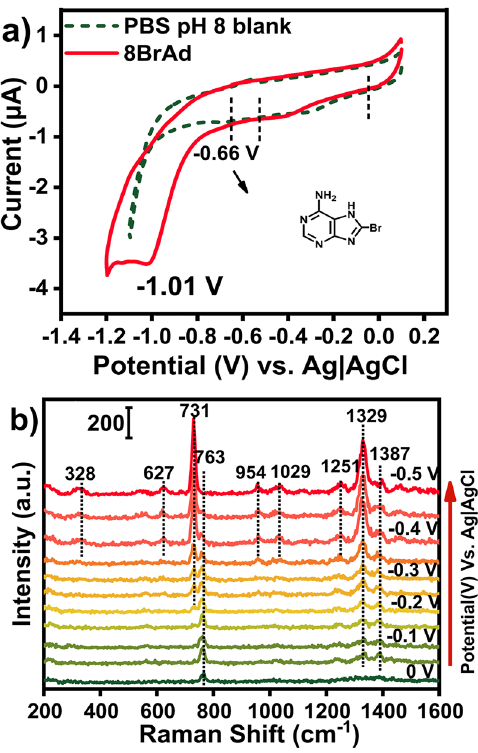
Figure 5: (a) Cyclic-voltage curves of silver nanoparticles @ silver electrode in the presence (red line) and absence (dotted green line) of 8-BrAd. (b) EC-SERS of 8BrAd on AgNPs@Ag electrode (532 nm laser @ 0.1 mW)